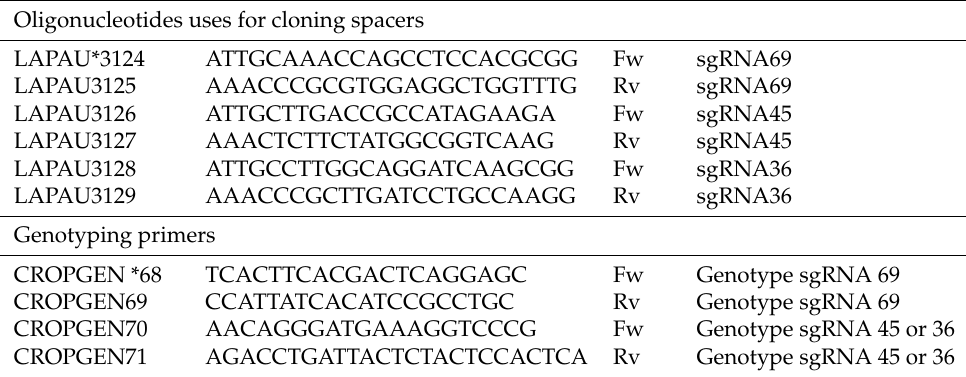
Table 2. Primers for